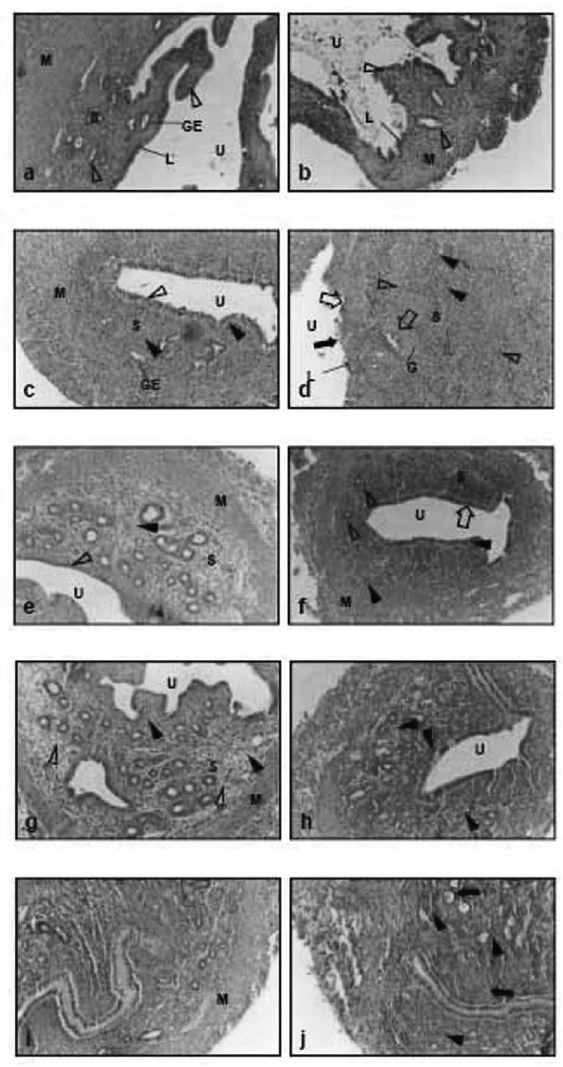
Figure 2. Cross sections of uterine horns from control animals and animals treated with the ‘minimum dose’ of LPS on day 0.5 of pregnancy. Note macrophages (closed arrow heads), mitotic bodies (open arrow heads), necrosis (closed arrow), hyperplasia (open arrow heads), stroma (S), luminal epithelium (LE), glandular epithelium (GE), myometrium (M) and uterine lumen (UL). Panels (a), (c), (e), (g) and (i) – show cross sections of uterine horns from control animals on days 0.5, 1.5, 2.5, 3.5 and 4.5 of pregnancy, respectively. Panels (b), (d), (f), (h) and (j) – show cross sections of uterine horns on days 0.5, 1.5, 2.5, 3.5 and 4.5 of pregnancy, respectively, from animals treated with the ‘minimum dose’ of LPS